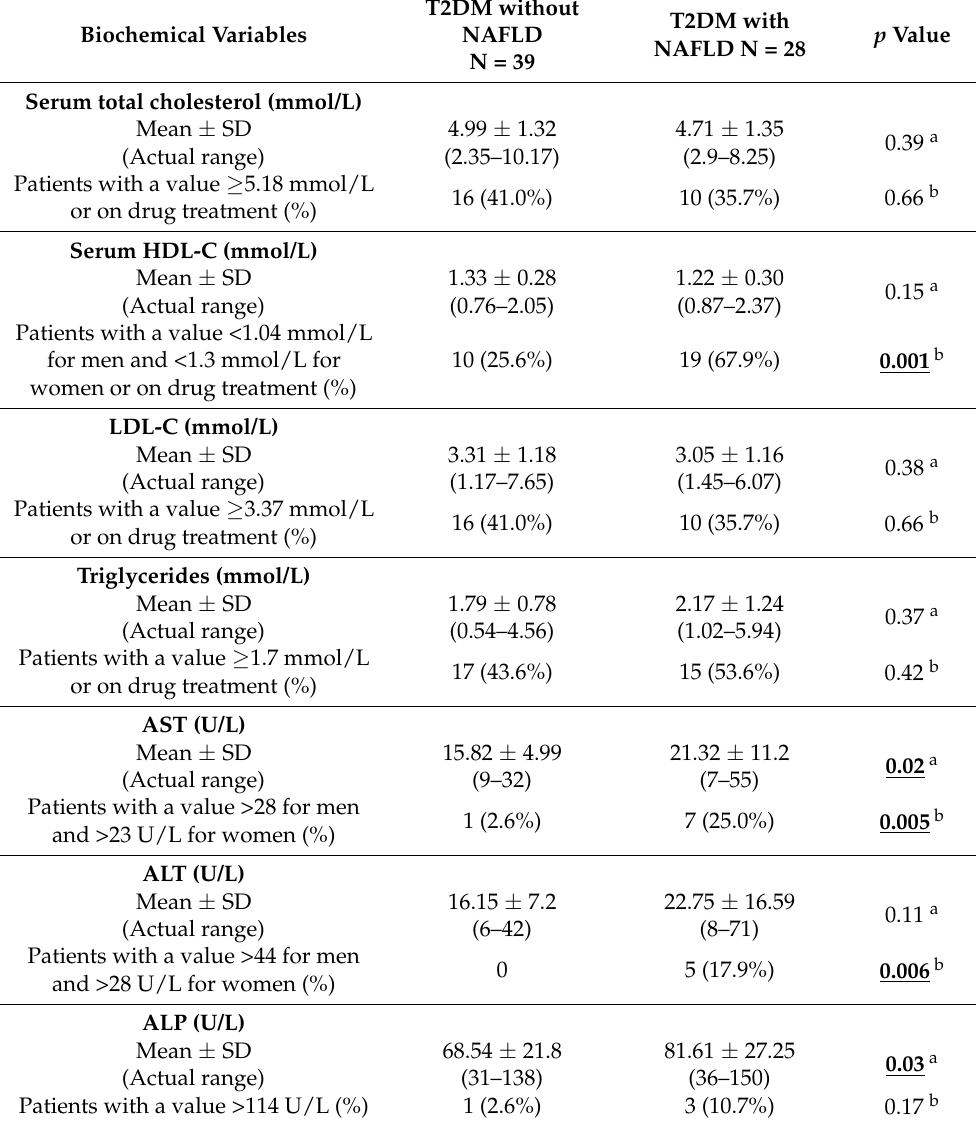
Table 2. Biochemical characteristics of T2DM patients with and without